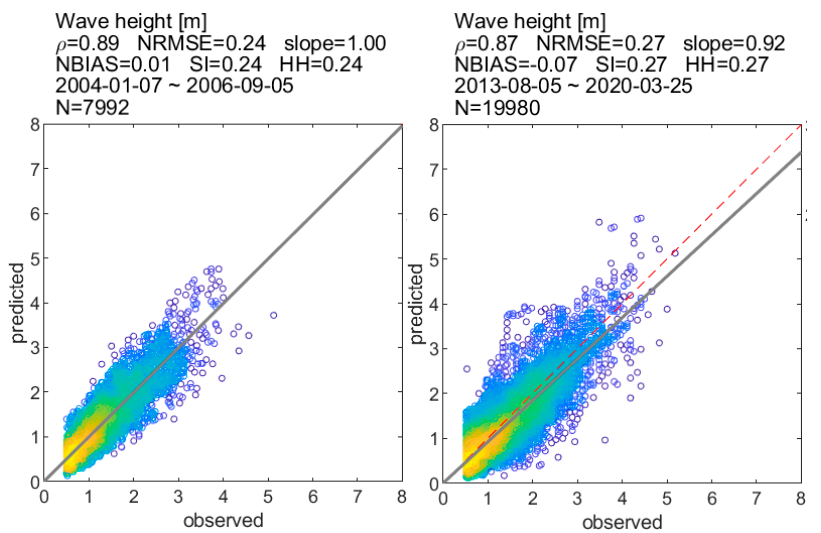
Figure 4. Comparison of significant wave height predicted and measured at Capo Linaro ( left ) and Civitavecchia CVT1 ( right ).